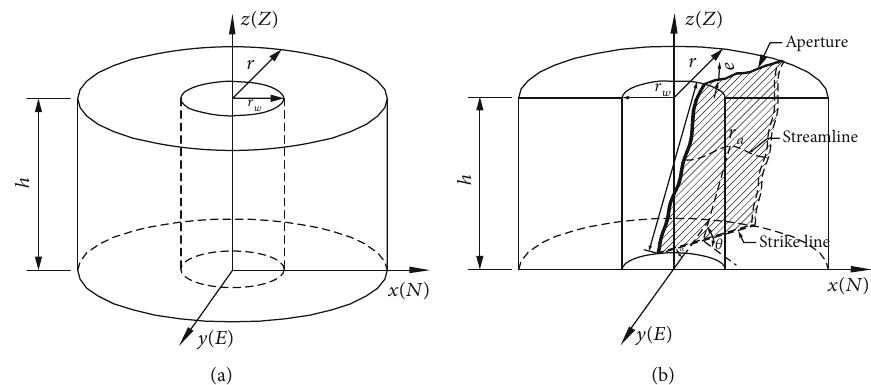
Figure 2: Radial fl ow diagram: (a) elevation view and (b) section